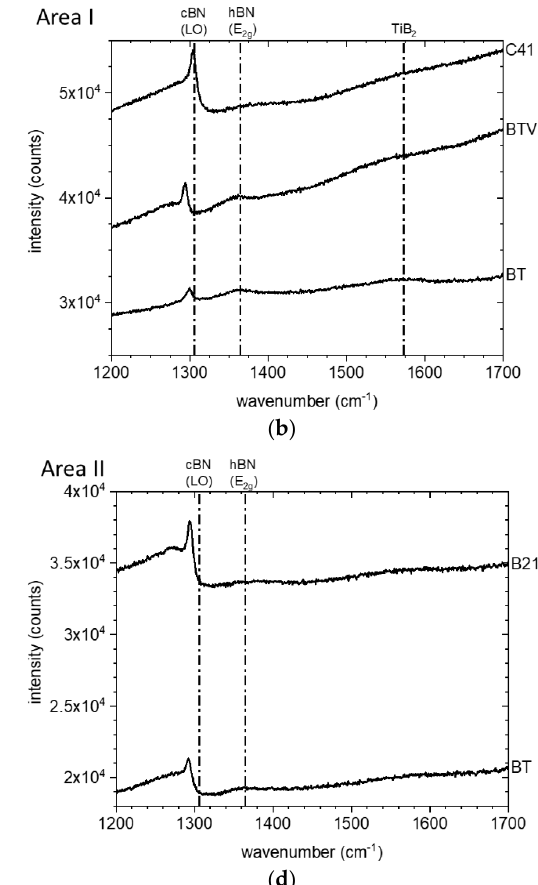
Figure 11. Raman spectra of the under argon tempered cBN powder B21 compared to the initial powder B21.